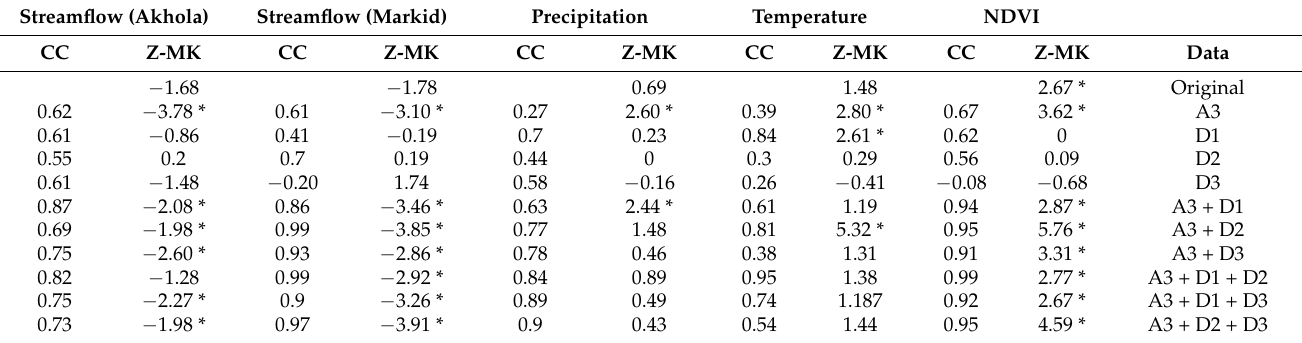
Table 7. Mann–Kendall Z-values and correlation coefficients of annual time series—Aji-Chay. Streamflow